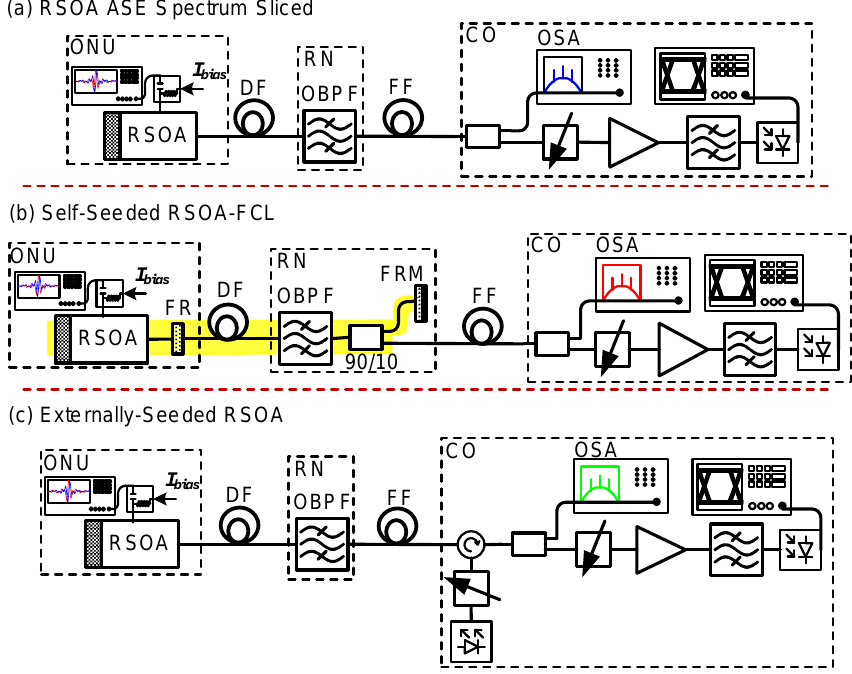
Figure 8. Experimental setups to characterize and compare the three schemes; ( a ) RSOA ASE spectrum-sliced scheme; ( b ) self-seeded RSOA-FCL; ( c ) externally seeded RSOA. In all setups, the transmitter is placed at the optical network unit (ONU) and the receiver is placed at the central office (CO). An optical bandpass filter (OBPF) mimics the WGR WDM filter at the remote node (RN). In ( b ), a Faraday rotator (FR) and FR-mirror (FRM) are placed at the ONU and the RN, respectively, for polarization control in the RSOA-FCL [35], shown by the yellow shading. The ONU is connected to the RN and the CO through the distribution fiber (DF) and the feeder fiber (FF),